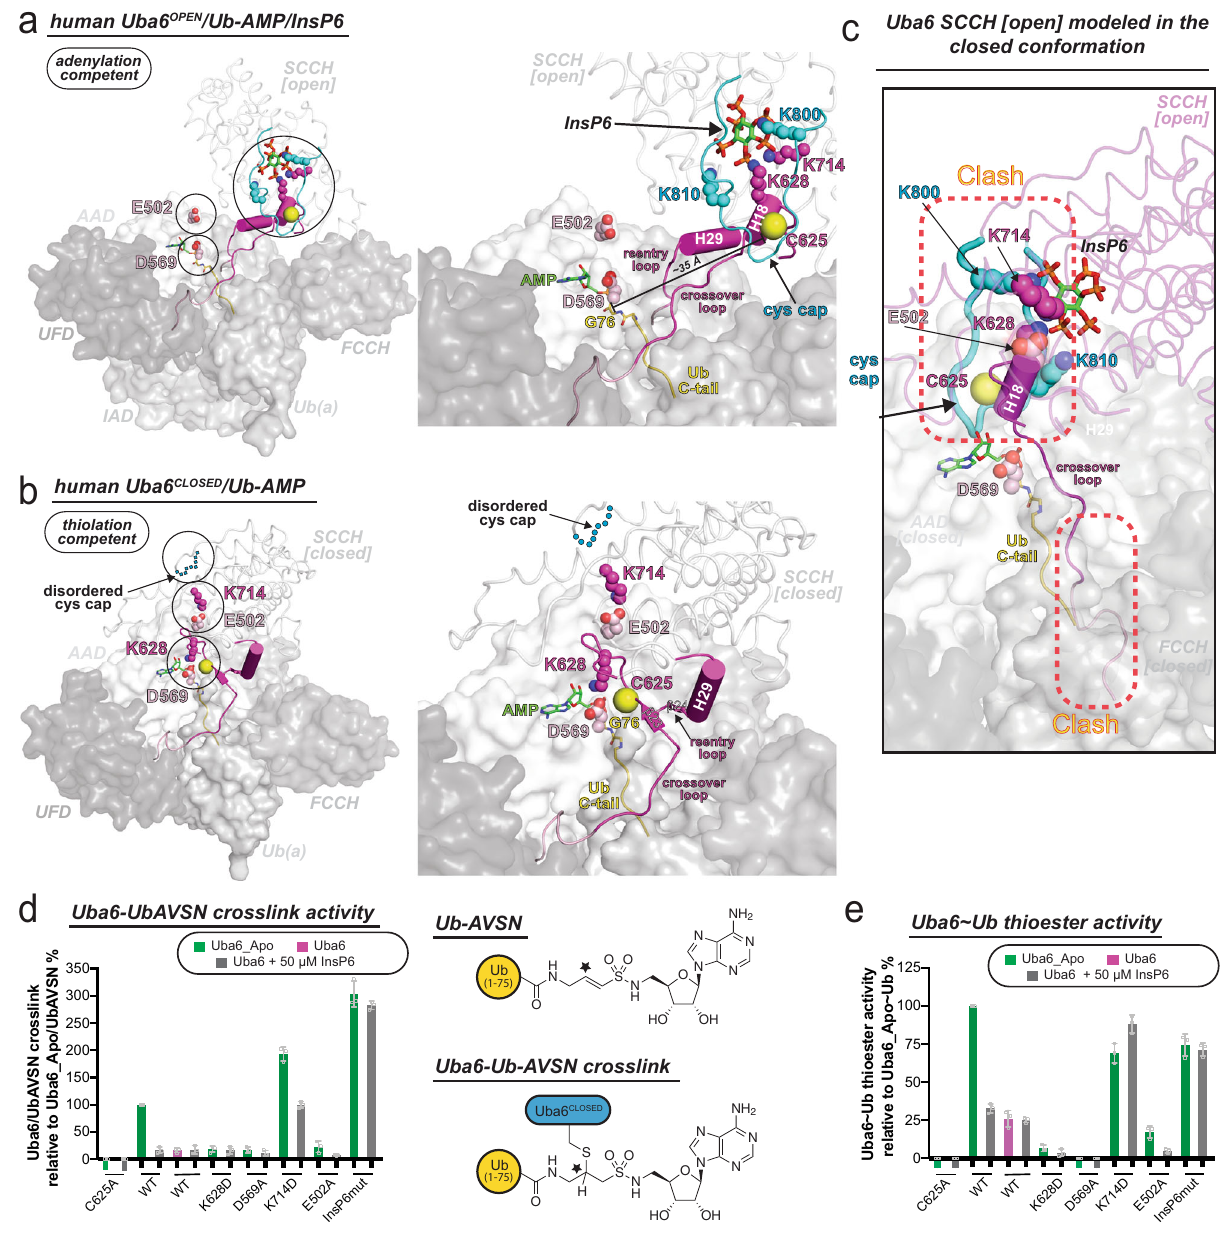
Fig. 5 | Mechanism of InsP6 modulation of Uba6 activity and stability. a , b The Uba6open( a )andUba6closed( b )structuresareshownassurfacerepresentations except for the SCCH domains, which are shown as loops. Elements that undergo conformational changes in the SCCH domain during transition from the adenyla- tiontothiolation-competentstateareshownascartoons.Selectedaminoacidsare shownasspheres. InsP6and AMP are shownassticks. Disordered cys cap is shown as cyan circles. c SCCH domain from the Uba6 open structure modeled in the closed conformation. SCCH open (shown as loops), was superimposed onto the SCCH domain of the Uba6 closed structure with Uba6 shown as surface repre- sentation. The steric clash between elements from SCCH [open] including cys cap, Helix18,crossoverloop,andreentryloopwithUba6arehighlightedbydashedred rectangles. d Structure – functionanalysisofUba6sidechainsdepictedin a and b in